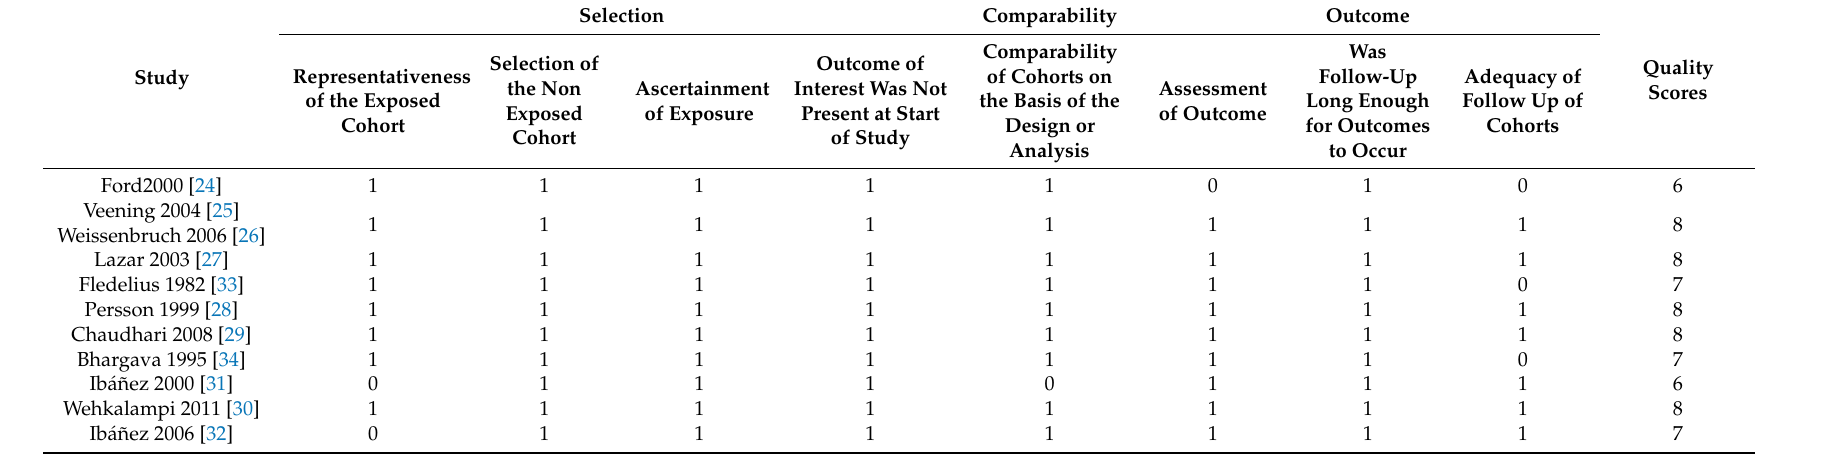
Table 2. The Newcastle–Ottawa Scale (NOS) for assessing the methodology